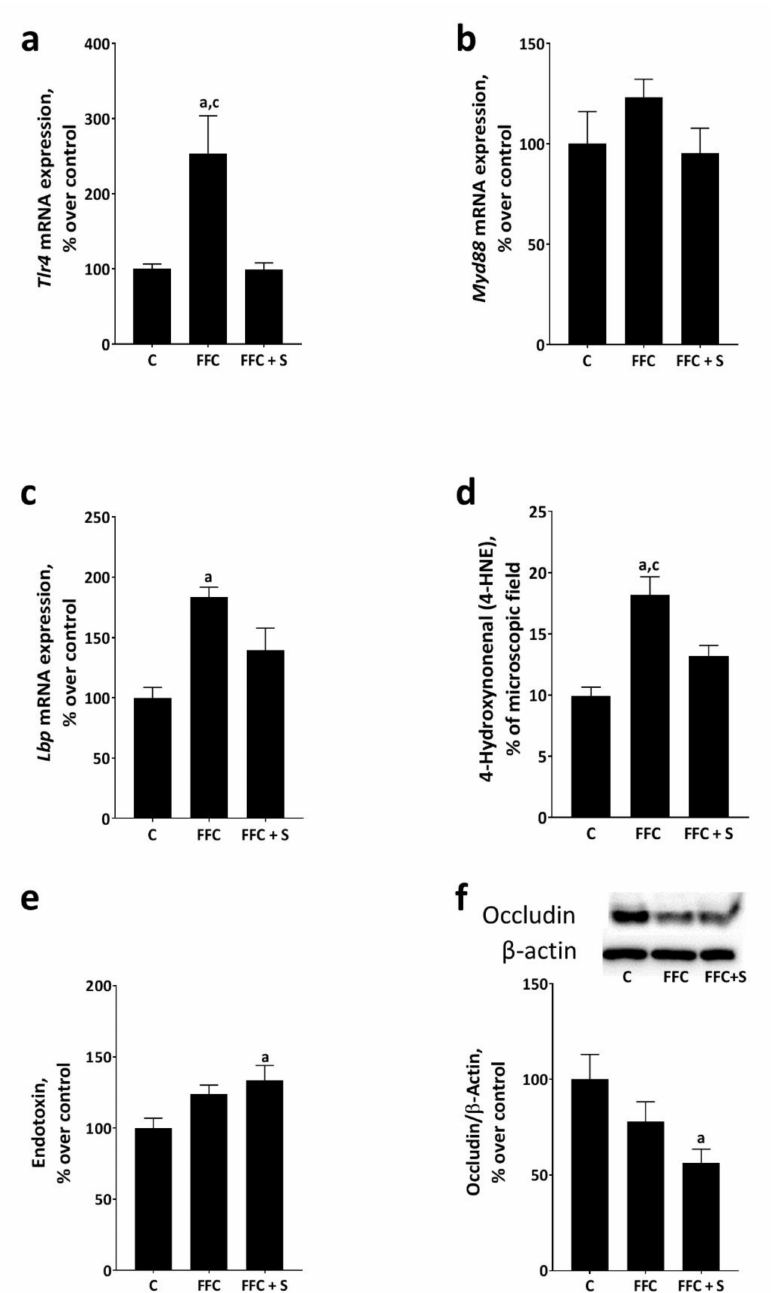
Figure 3. Effect of fortifying the fat-, fructose-, and cholesterol-rich diet with 4E% soybean oil on portal endotoxin levels and markers of TLR4 signaling in the liver tissue of mice. Hepatic mRNA expression of ( a ) toll-like receptor 4 ( Tlr4 ), ( b ) myeloid differentiation primary response 88 (Myd88) , ( c ) lipopolysaccharide binding protein (Lbp) , ( d ) densitometric analysis of 4-hydroxynonenal (4-HNE) protein adduct staining in liver sections, ( e ) portal plasma endotoxin concentration, and ( f ) protein levels of occludin normalized to beta-actin ( β -actin). Data are presented as means ± SEM, n = 6–8 mice per group with n = 6–8 livers being analyzed per group and measurements. Data of Tlr4 were log-transformed before statistical analysis. C: control diet; FFC: fat-, fructose-, and cholesterol-rich diet; FFC + S: fat-, fructose-, and cholesterol-rich diet supplemented with soybean oil. a p ≤ 0.05 compared to C. c p ≤ 0.05 compared to FFC +